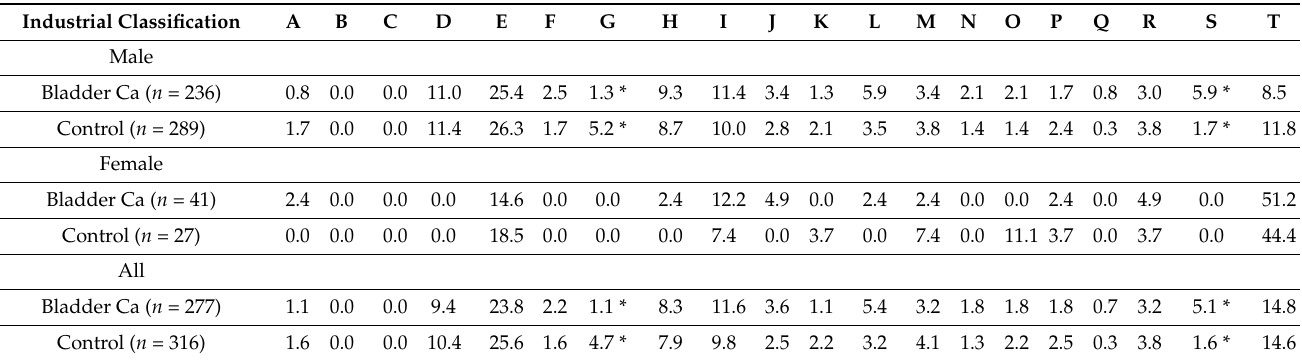
Table 2. Distribution of industrial classification